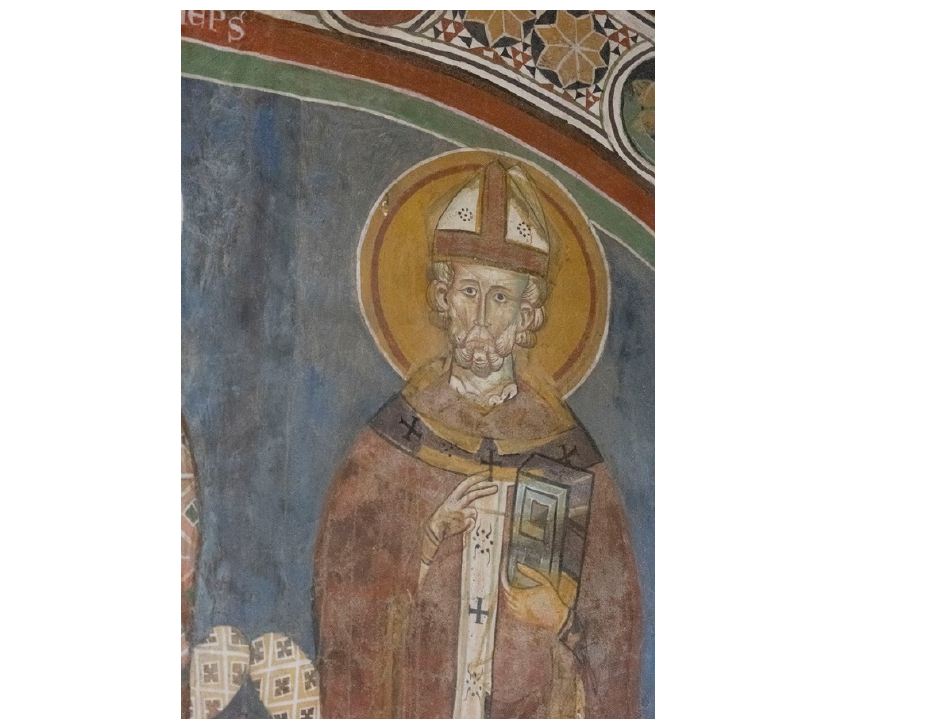
Figure 11. Sacro Speco, Subiaco (Italy), Lower Church. Fresco. Lunette, particular of St. Nicholas. Photo: Davide Giannetti.